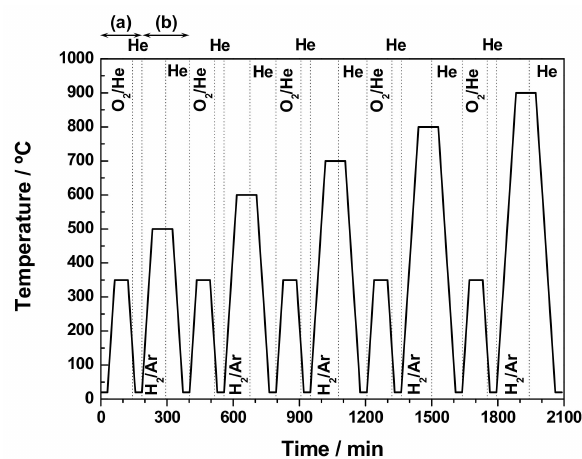
Figure 1. Schematic description of the stages involved in the successive thermochemical ageing treatmentsappliedtothefreshundopedandLn-dopednanostructuredZrO 2 -CeO 2 samples. Theheating rate was 10 ◦ C · min − 1 in all